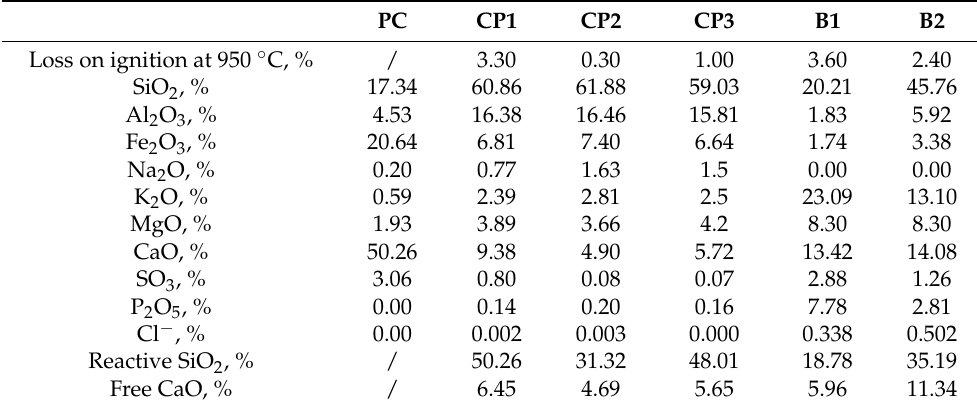
Table 3. Chemical composition of